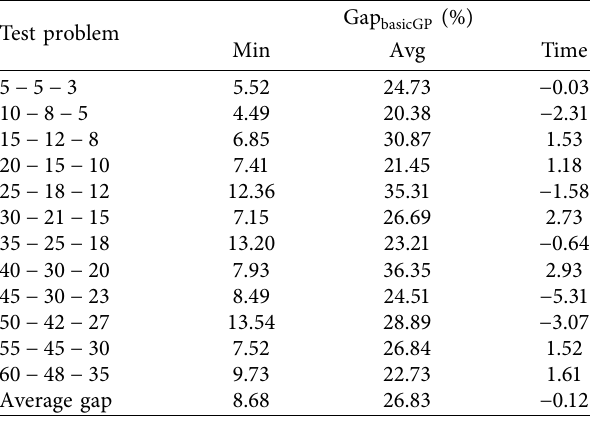
Table 6: Comparison with basic GP.